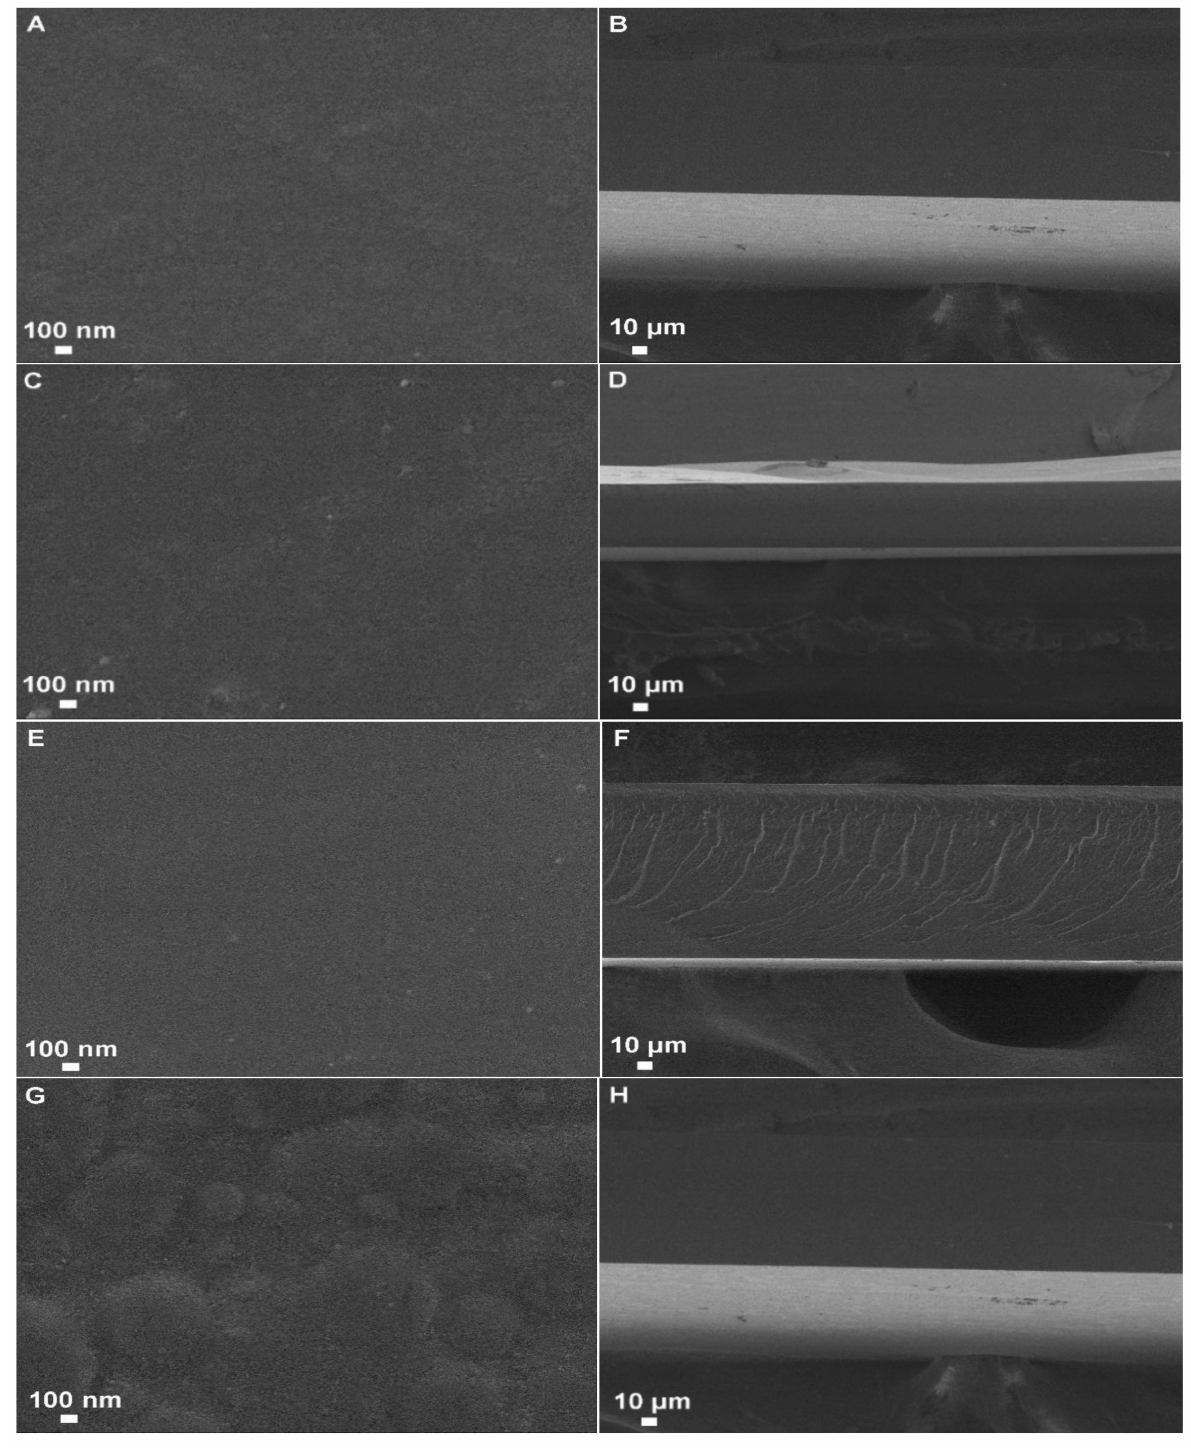
Figure 1. SEM images of the film’s surface ( A , C , E , G ) and cross-sections ( B , D , F , H ). A , B : C-PVP-1:9; C , D : C-PVP-1:3; E , F : PVP-SD-1:9; G , H :